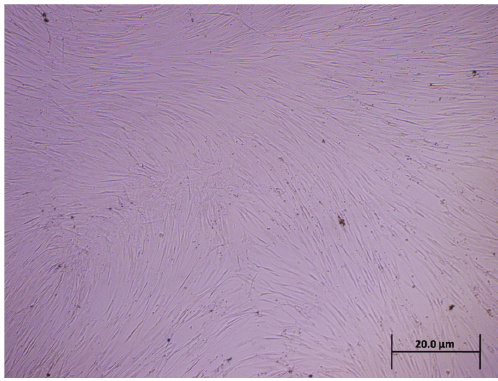
Figure 1: Inverted microscope photomicrograph shows morpho- logical characteristic of MSCs (spindle shape) derived from rat bone marrow in passage 3. Scale bar: 20 μ